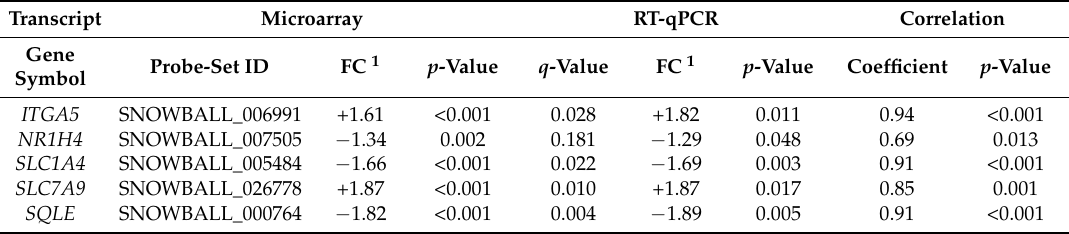
Table 5. Comparison of microarray and quantitative real-time PCR (RT-qPCR) results for selected transcripts to verify microarray data; Fold change